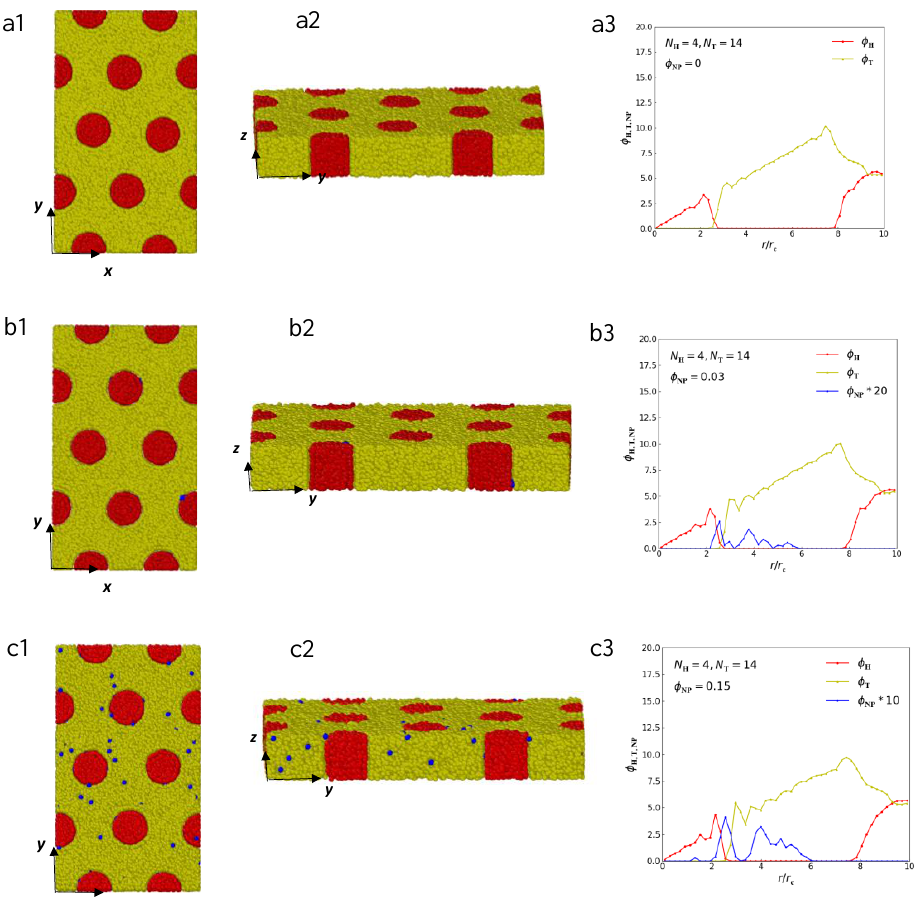
Figure 4. Representative hexagonal microstructures of lipid–nanoparticle mixtures with N H = 4 and N T = 14. The microstructures for different views are listed on the left and middle, and the radial density profiles are listed on the rightmost side. ( a1 ) The front view of pure lipid molecule with φ NP = 0. ( a2 ) The side view of pure lipid molecule. ( a3 ) The radial density distribution of pure lipid molecule. ( b1 ) The front view of lipid–nanoparticle mixtures with φ NP = 0.03. ( b2 ) The side view of lipid–nanoparticle mixtures with φ NP = 0.03. ( b3 ) The radial density distribution of lipid– nanoparticle mixtures with φ NP = 0.03. ( c1 ) The front view of lipid–nanoparticle mixtures with φ NP = 0.15. ( c2 ) The side view of lipid–nanoparticle mixtures with φ NP = 0.15. ( c3 ) The radial density distribution of lipid–nanoparticle mixtures with φ NP =